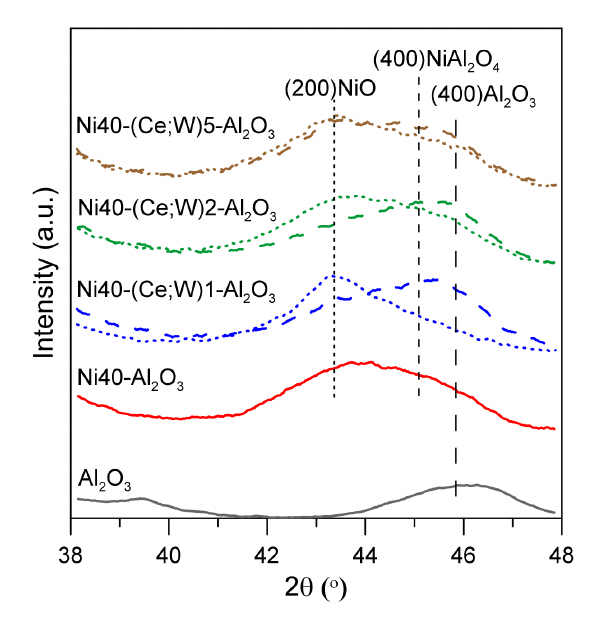
Figure 2. X-ray diffraction patterns of catalysts after calcination in selected region of 2 theta angle; Ce-promoted nickel catalysts—dotted lines, W-promoted catalysts—dashed